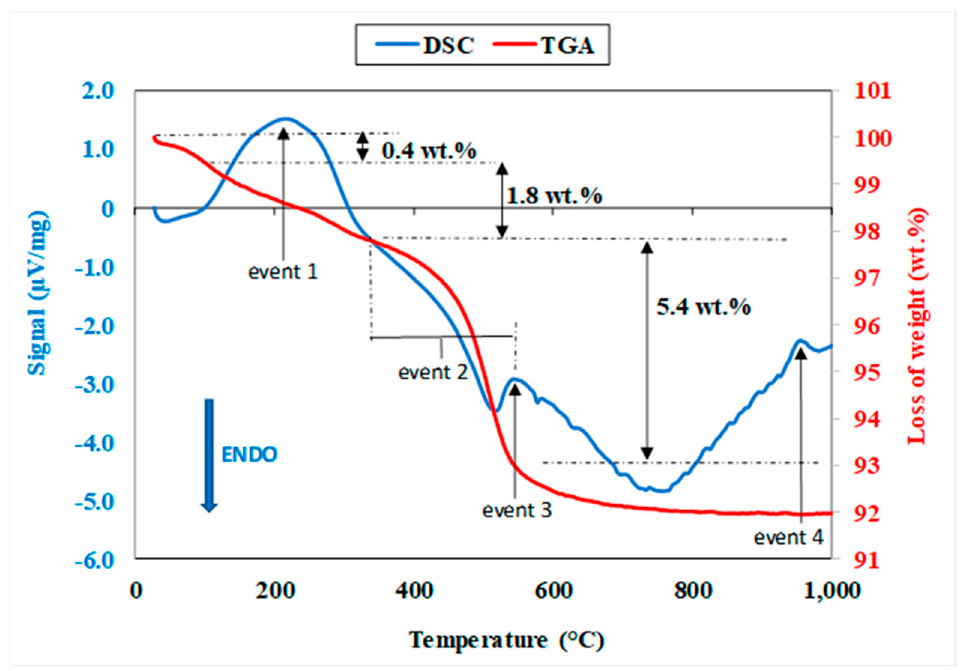
Figure 4. DSC-TGA curves of Louaga sample.